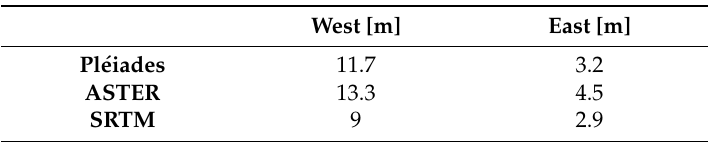
Table 6. Calculated root mean square error (RMSE) of DGPS and digital elevation model (DEM) heights for both